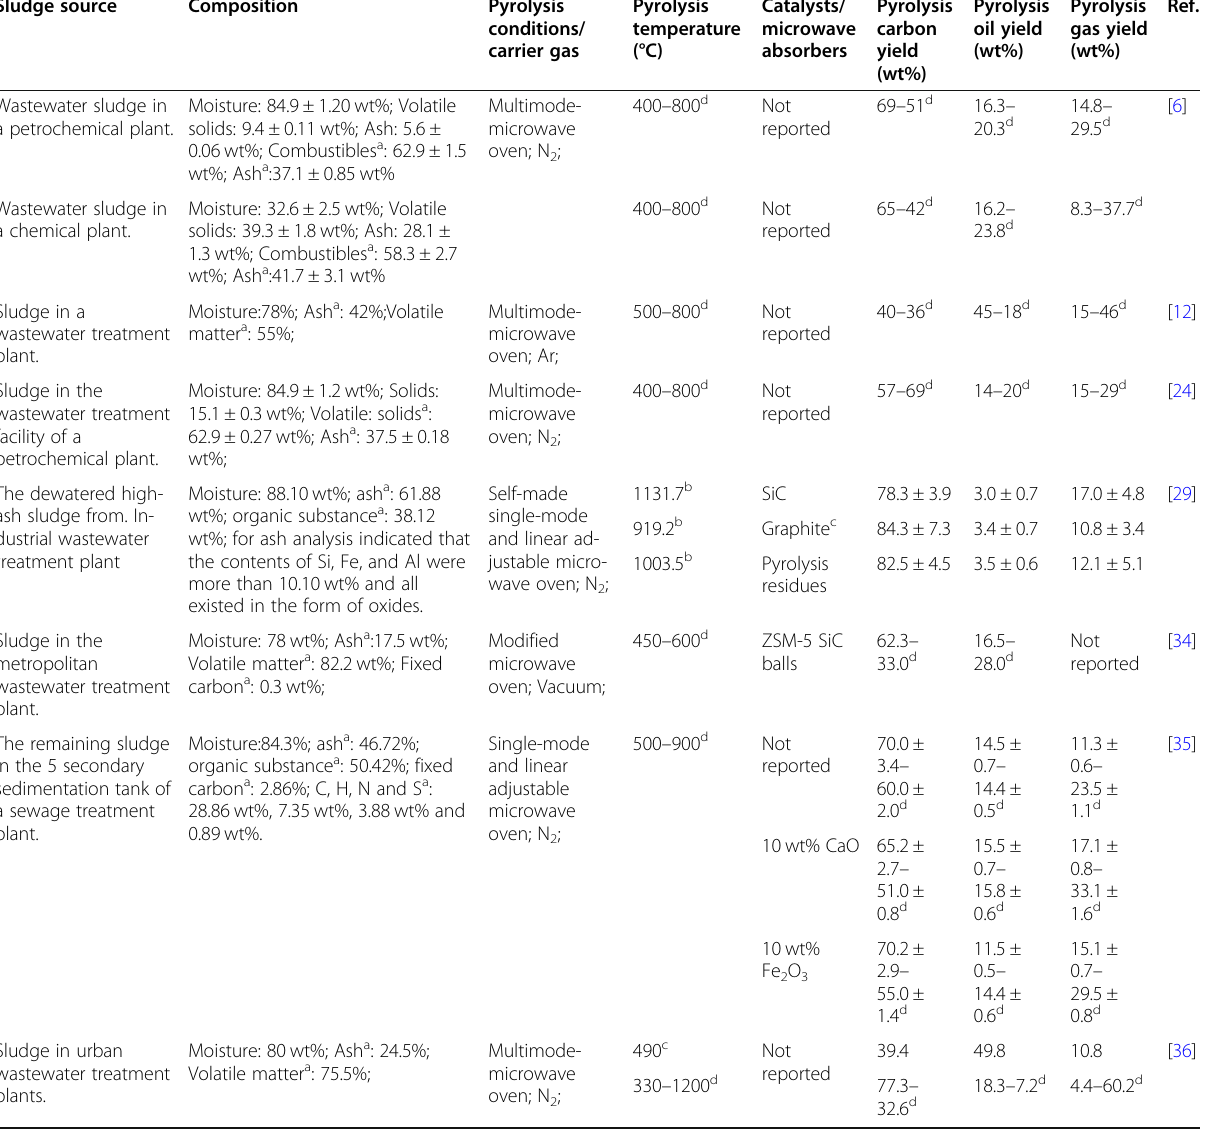
Table 1 The product yields of microwave pyrolysis sludge under different moisture content and operating conditions Sludge source